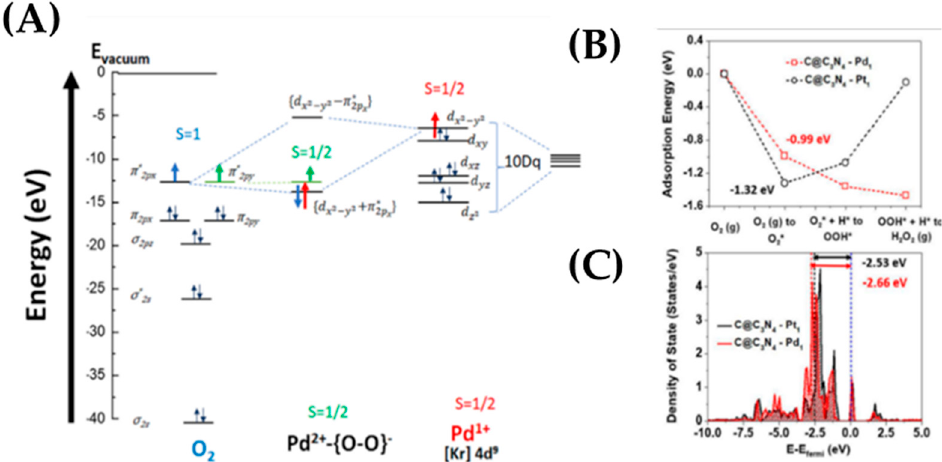
Figure 24. ( A ) Suggested coupling Figure for the Pd 2+ {O-O} - state for Pd on TiO 2 . Taken from 25 ( Β ) Energy profile of intermediates on atomic Pd and Pt along ORR pathways at UV for the Pd/C@C 3 N 4 material. Adapted from Reference 25, with permission. ( C ) Calculated density of states of d-band of Pd and Pt. for the for the Pd/C@C 3 N 4 material. Adapted from [80] with permission.